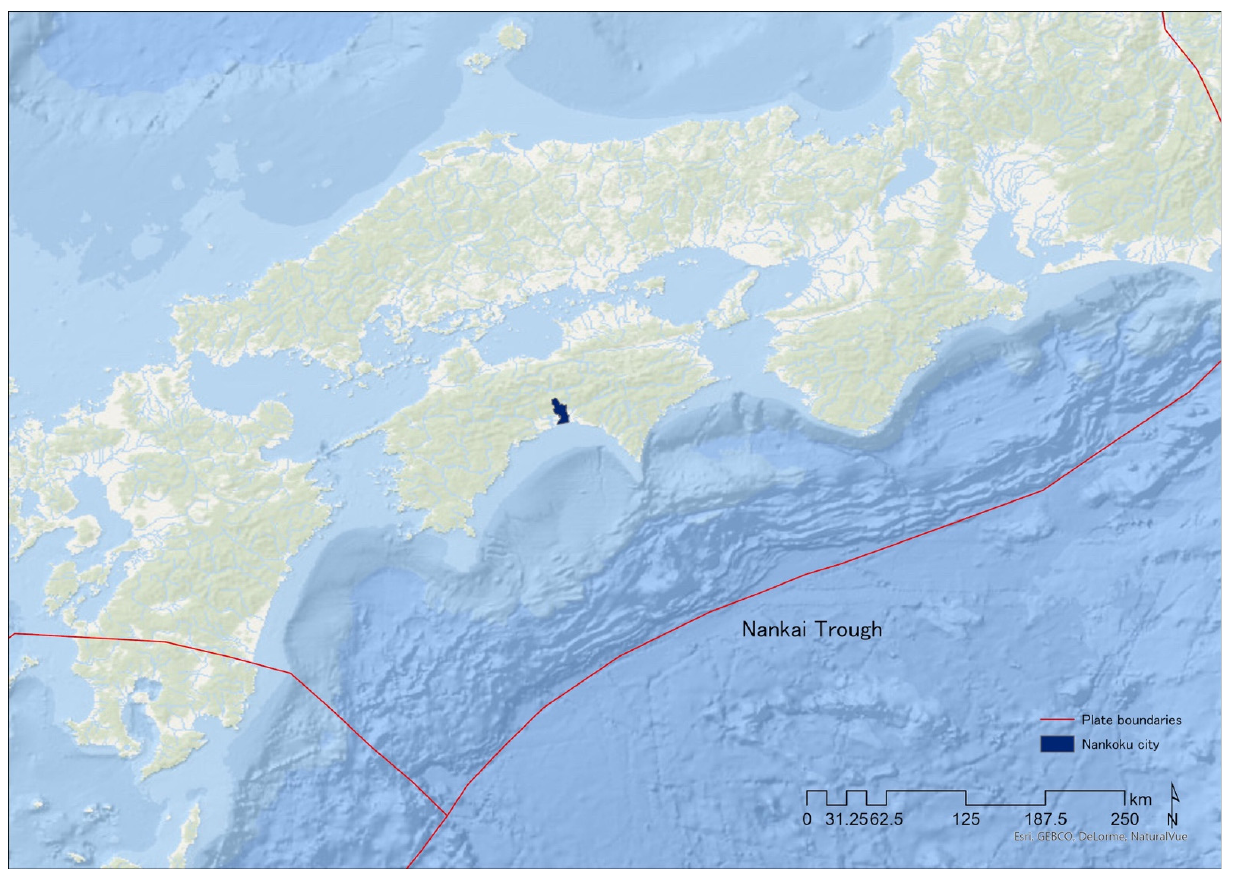
Figure 2. Target area of K-DiPS demonstration experiment in Japan.